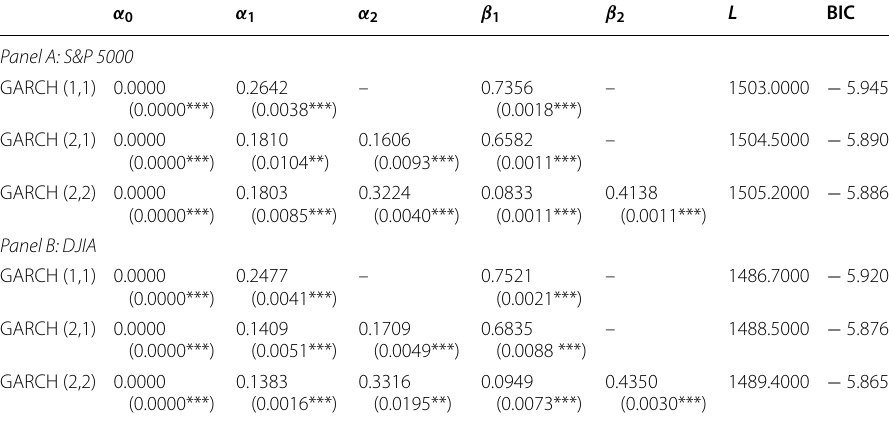
Table 8 displays results of tests for the GARCH effect for both S&P 500 and DJIA over the period January 1st, 2019 to June 30th, 2020. L and BIC are presented in log values P values are provided in the parentheses ** and *** indicate significance at the 5% and 1% levels,